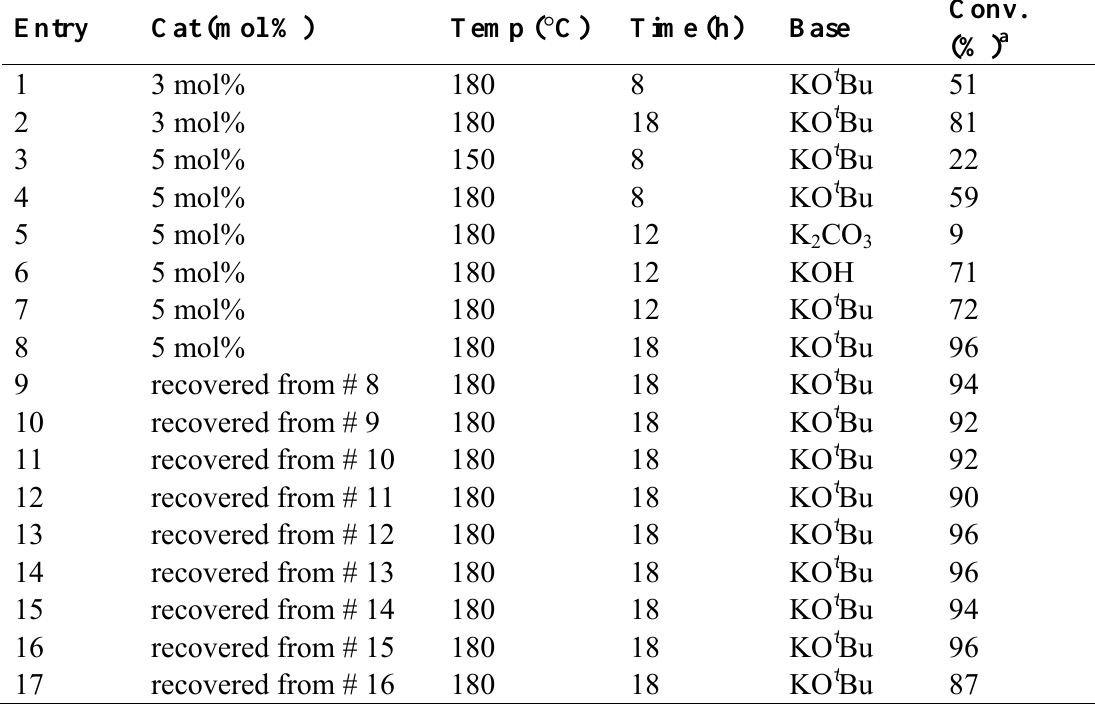
Table 1. Screening reaction condition for N -arylation of iodobenzene with